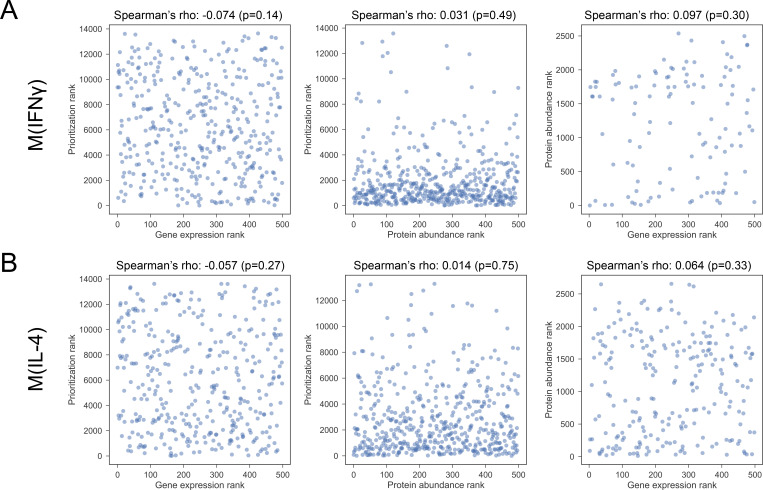
(A) The Spearman’s correlation between pairs of constituent rankings for M(IFNγ). (B) The Spearman’s correlation between pairs of constituent rankings for M(IL-4).